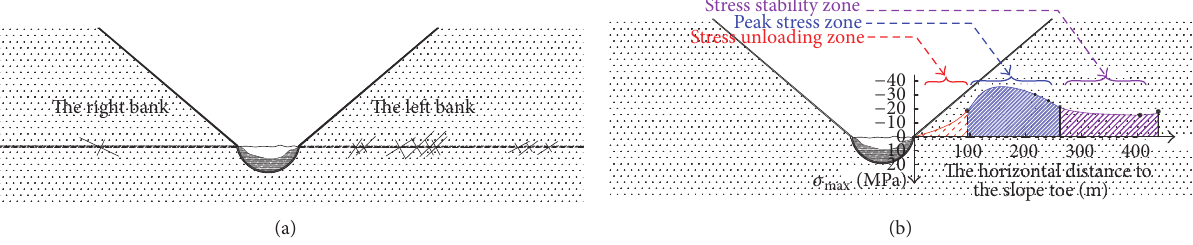
Figure 10: Directions of the maximum and minimum principal stresses and in situ stress distributions in field measurement: (a) directions of the maximum and minimum principal stresses; (b) in situ stress distribution in the mountain.